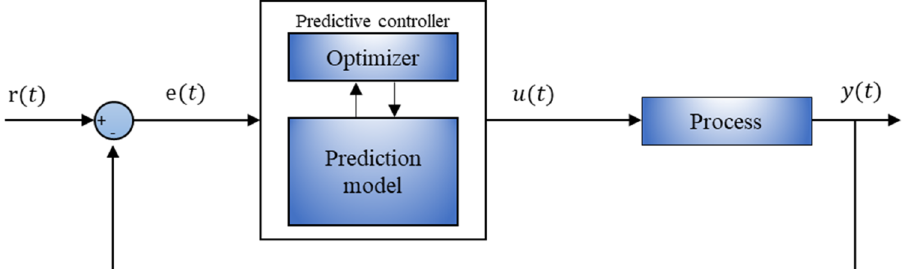
Figure 2: Predictive controller